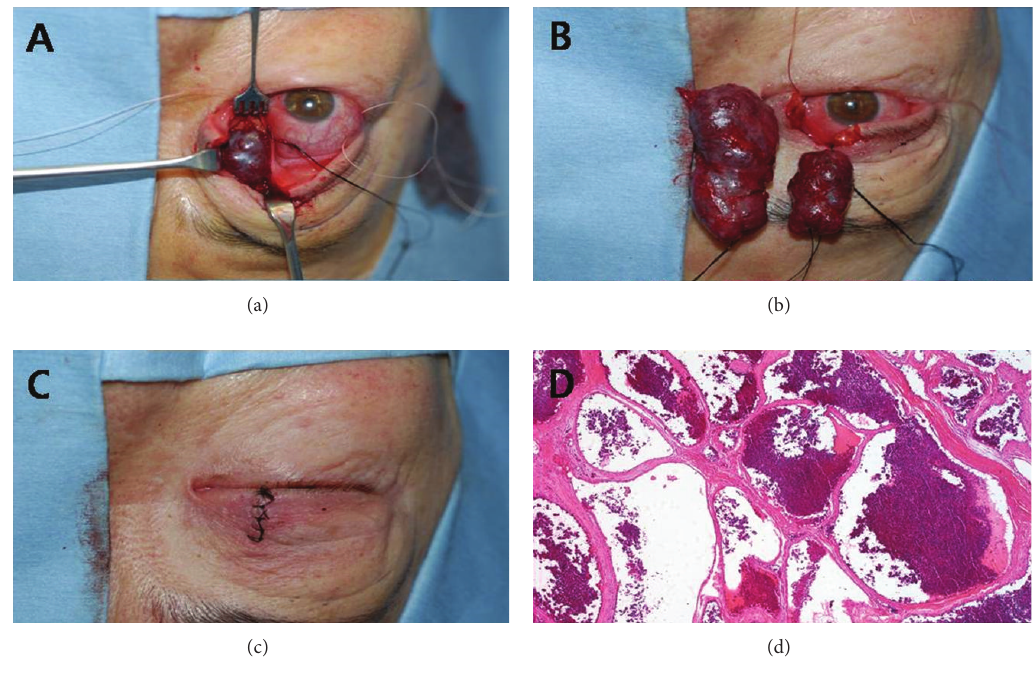
Figure 2: (a) Full thickness vertical lid marginal incision is made at the junction of the medial and central thirds of the upper lid. (b) After all adhesions were released carefully, the two tumors were removed successfully. (c) The lid incision was repaired by the same method used for repair of a full thickness lid margin laceration. (d) Histopathologic examination reveals cavernous hemangioma consisting of dilated spaces filled with blood and septated by fibrous tissues (hematoxylin-eosin,